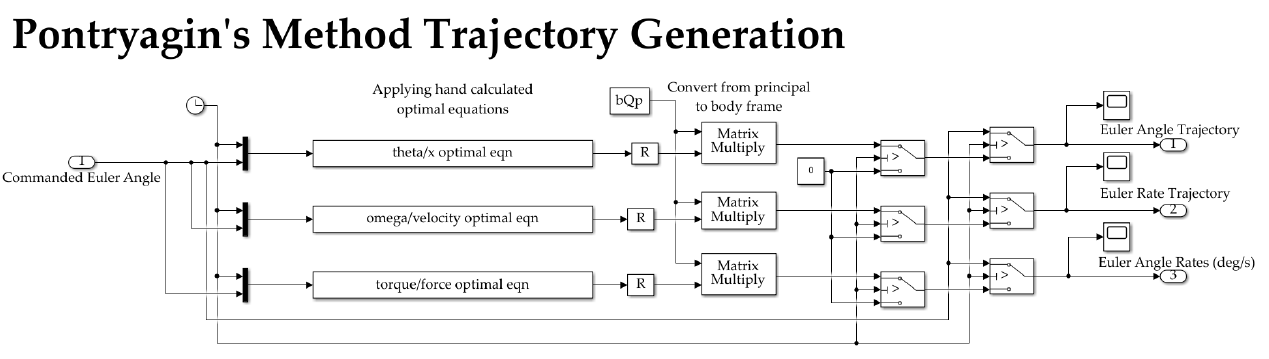
Figure A3. MatLab model with complete detailed display of the sinusodial generation block in the trajectory Simulink subsystem.